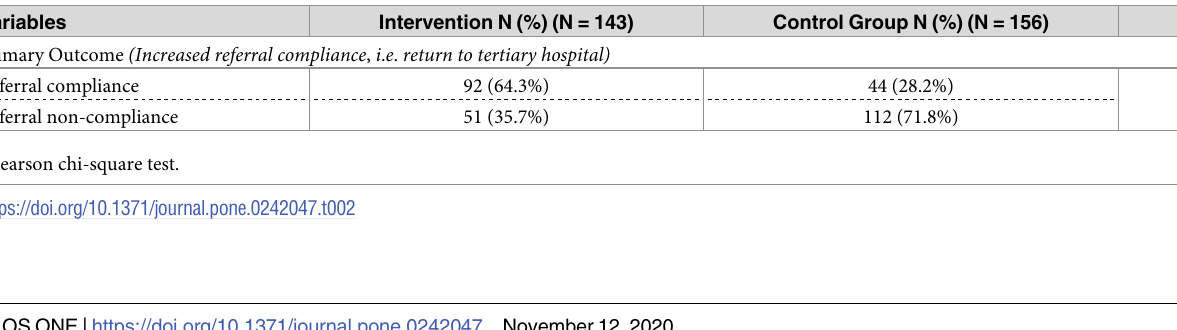
Table 2. Comparison of primary outcome between intervention and control